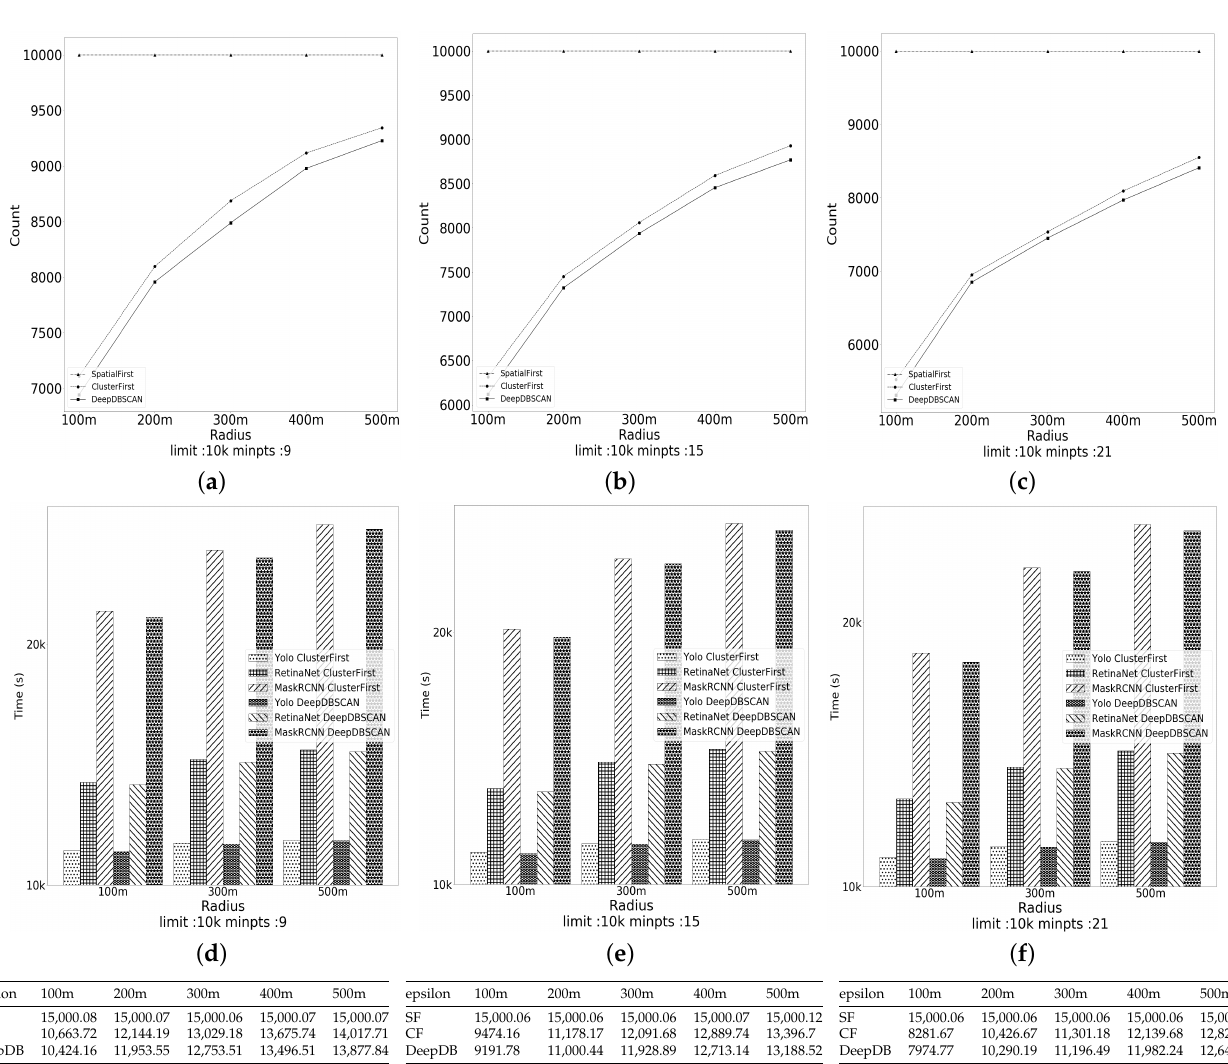
Figure 8. Effect of the radius. ( a – c ) number of object detections when minpts 9 to 21; ( d – f ) The time cost of each object detection model when minpts 9 to